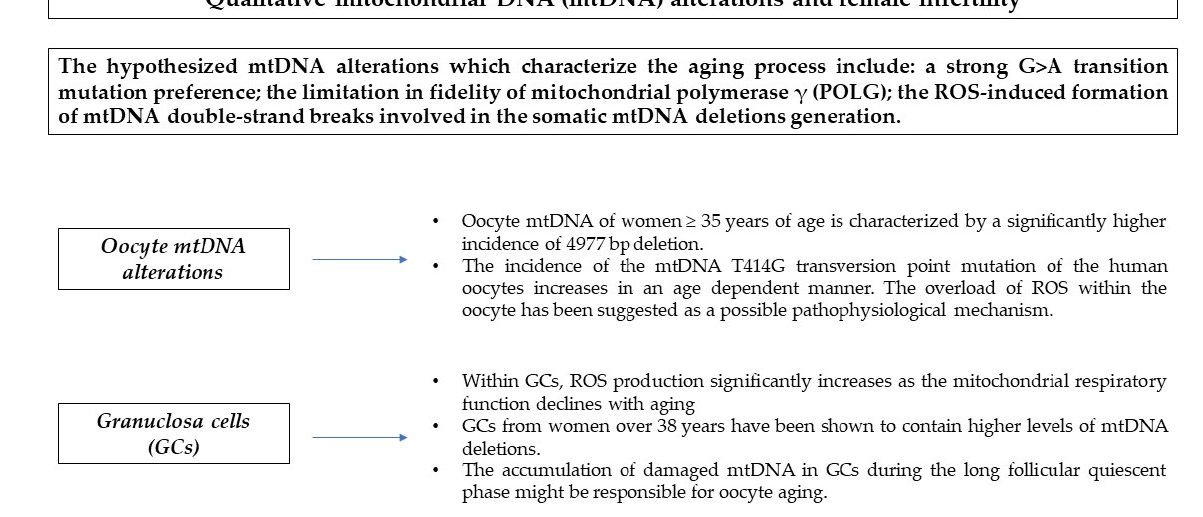
Figure 1. Qualitative mtDNA alterations and female